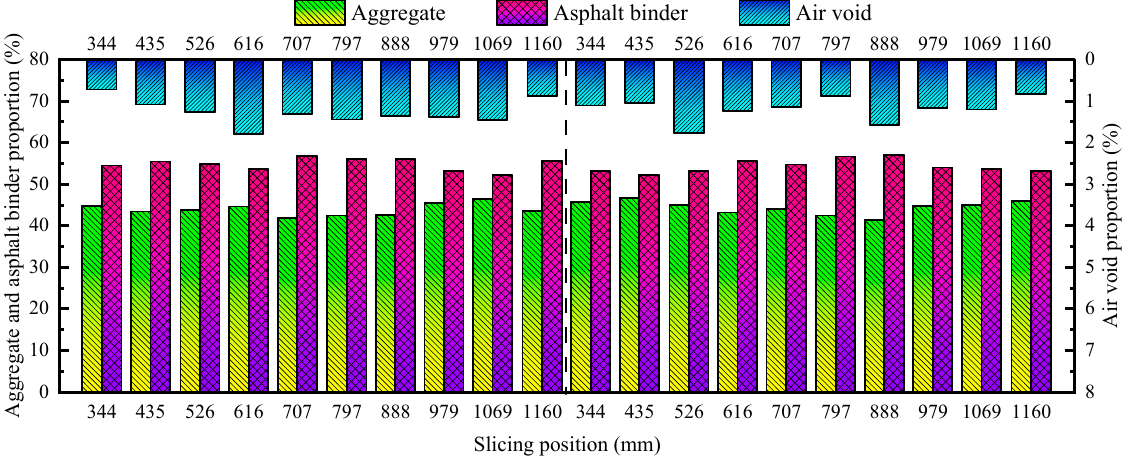
Figure 9. The proportion of air voids, aggregates and binder.